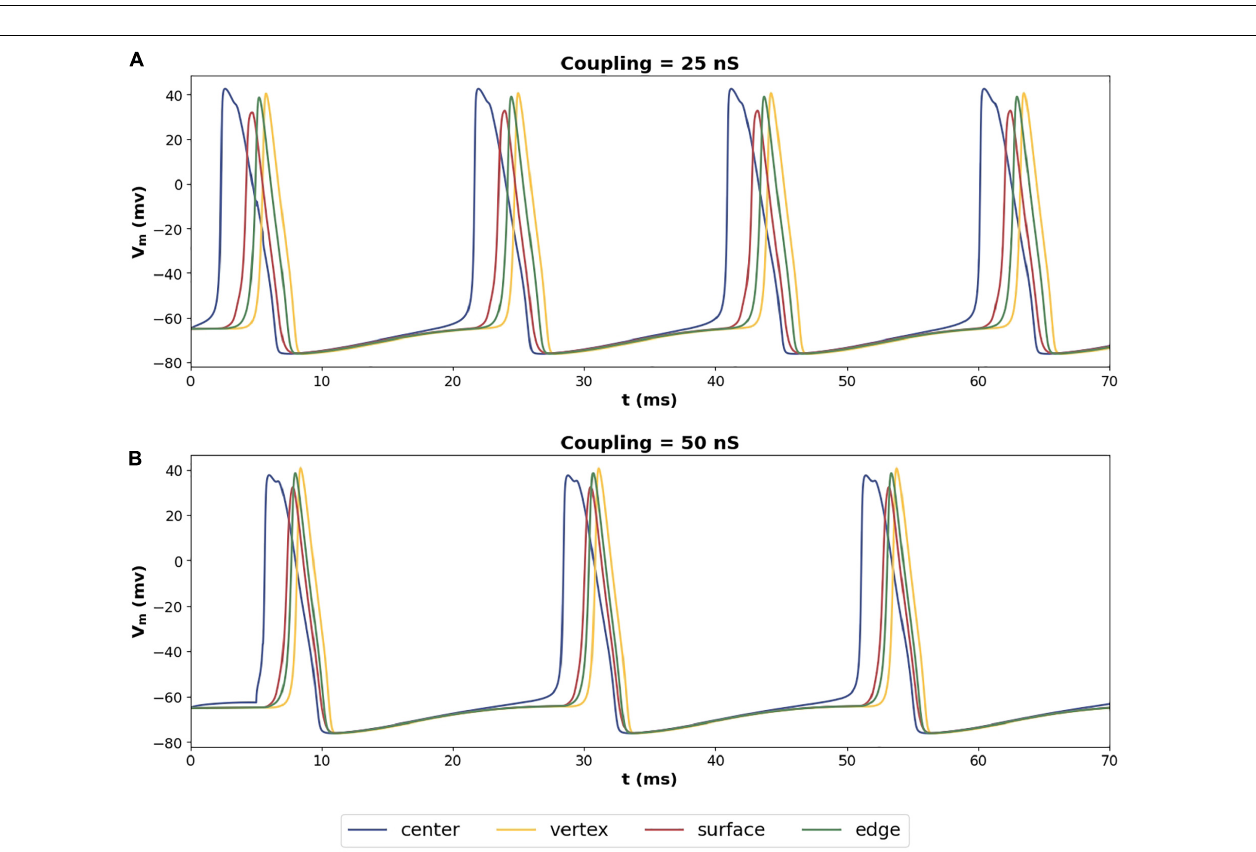
FIGURE 8 | (A) An illustration of a 5-cube syncytium showing locations where pacemaker cells were placed (one location per simulation) are highlighted with colored cells, while all other cells have been left uncolored for easier visualization. The bounding box (in black) indicates the extent of the syncytium. (B) Action potential oscillation frequency measured in a syncytium of size 5-cube under different locations of the AP initiating cell such as the central cell, a cell on the surface, a cell on an edge, and a cell located at a vertex of the syncytium. Note that the color of the cells in panel (A) corresponds to the traces in panel (B) .